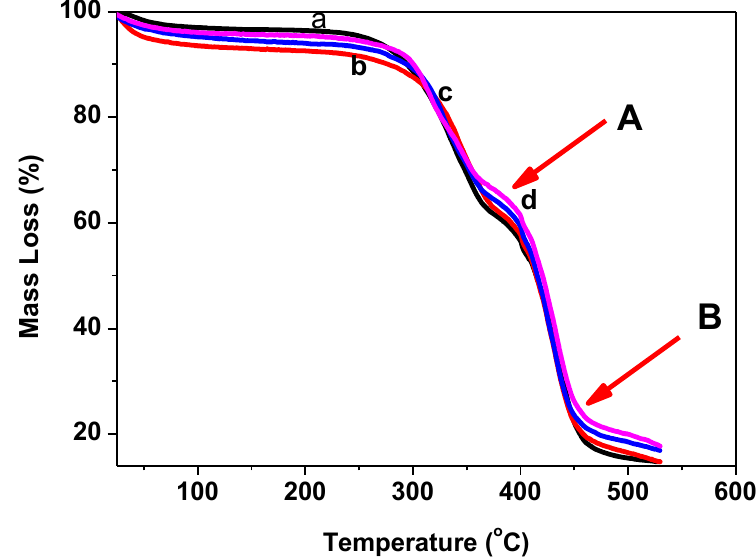
Figure 3. Thermogravimetric analysis (TGA) graphs of ( a ) Blank textile, ( b ) T–CH, ( c ) T–CH–OA–20, and ( d ) T–CH–OA–50.